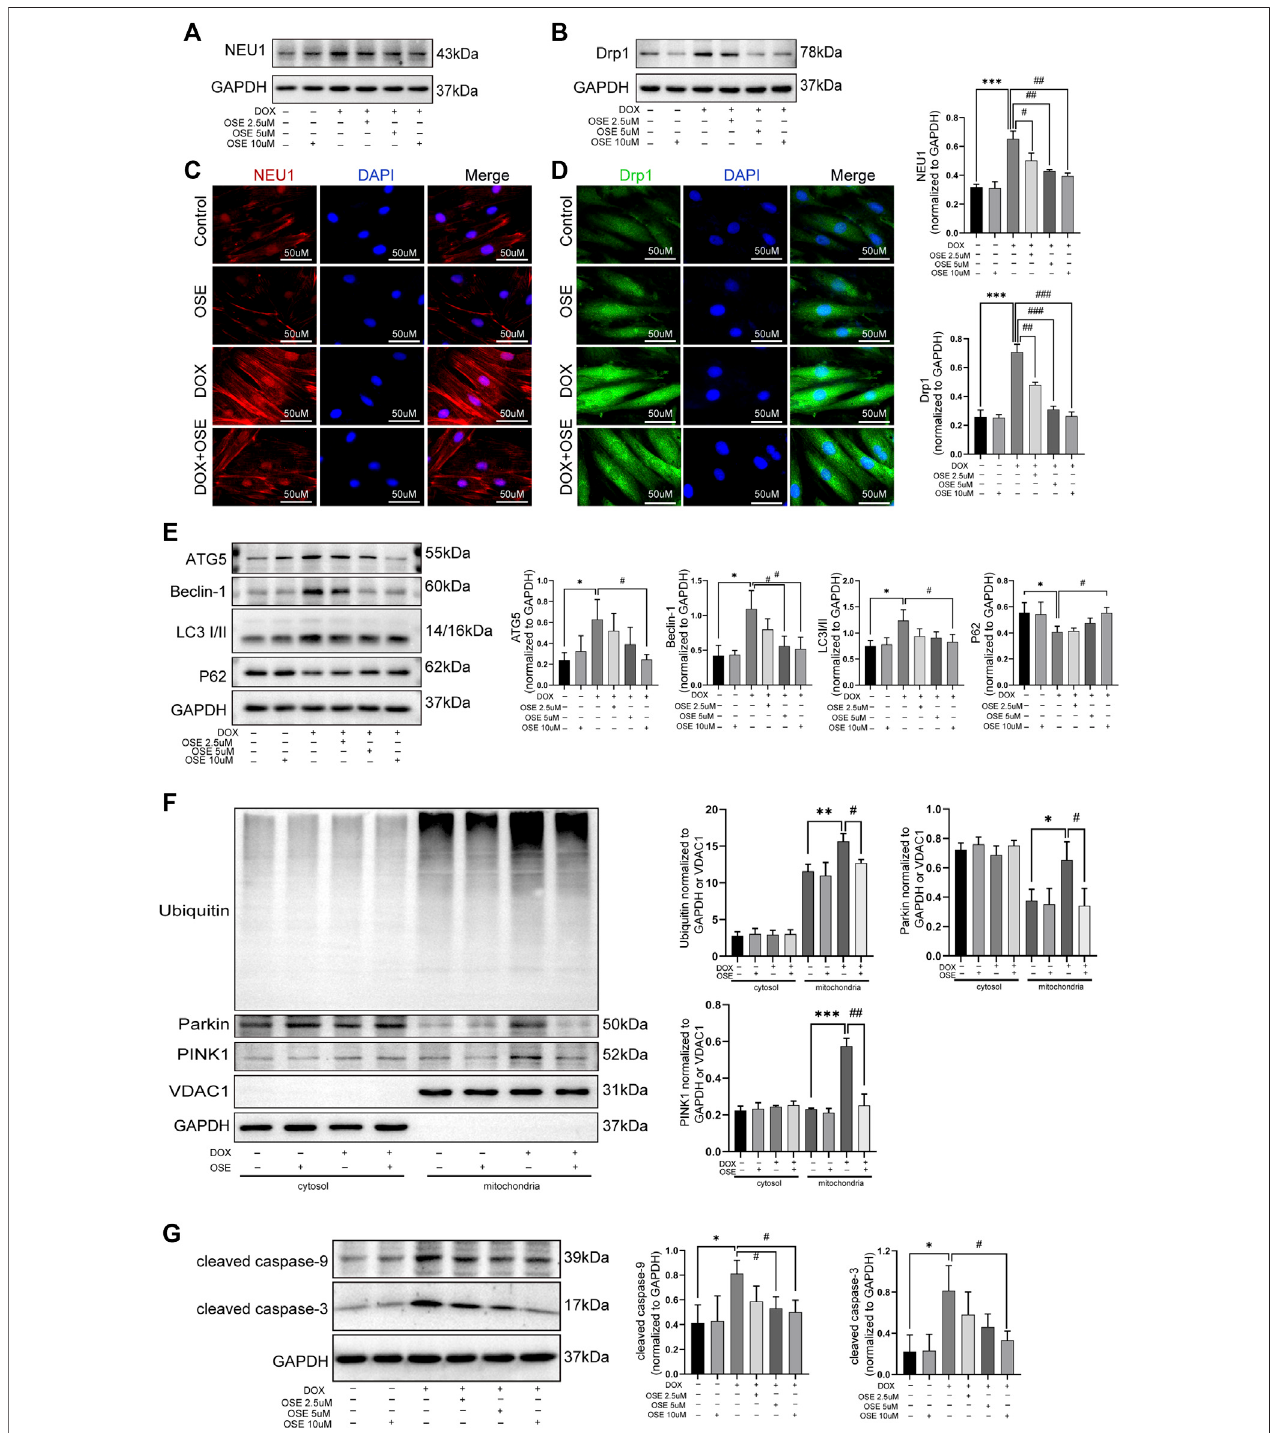
FIGURE 6 | OSE effectively blunted excessive mitochondrial fi ssion and mitophagy in DOX-exposed H9C2 cells. (A) OSE suppressed the elevated NEU1 expression induced by DOX in H9C2 cells in a dose-dependent manner. (B) OSE suppressed the elevated Drp1 expression induced by DOX in H9C2 cells in a dose- dependent manner. Representative immuno fl uorescent images of NEU1 expression (C) or Drp1 expression (D) after OSE treatment in DOX-induced H9C2 cells. (E) Western blot analysis revealed that OSE suppressed the excessive autophagy activation induced by DOX in H9C2 cells in adose-dependent manner. (F) Western blot analysis showed that OSE attenuated mitophagy activity in DOX-treated H9C2 cells in a dose-dependent manner through inhibiting PINK1 accumulation, Parkin recruitment, and ubiquitination on mitochondria. (G) OSE suppressed apoptotic activity in DOX-treated H9C2 cells in a dose-dependent manner. (* p < 0.05 vs. control group, ** p < 0.01 vs. control group, *** p < 0.001 vs. control group. ## p < 0.01 vs. DOX group, ### p < 0.001 vs. DOX group).